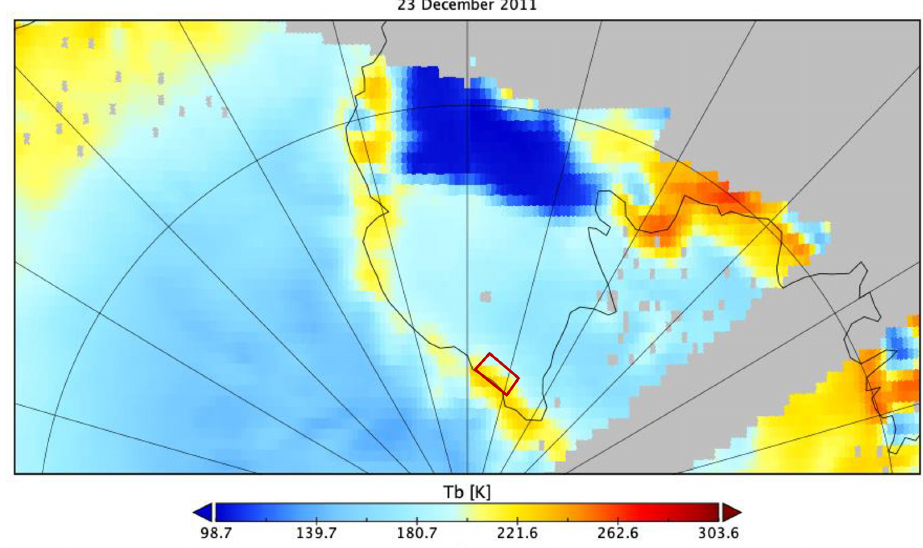
Figure B6. SSMIS horizontally polarized 19.35GHz brightness temperature over part of West Antarctica and the RIS on 24 December 2011, with the red box denoting the bounding region containing the Tom and Sabrina